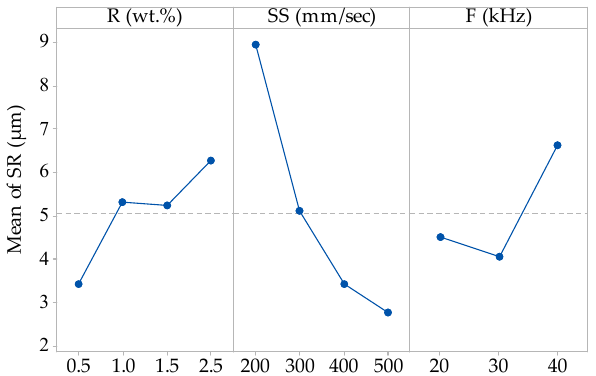
Figure 7. Main e ff ects plot for SR. Figure 7. Main effects plot for